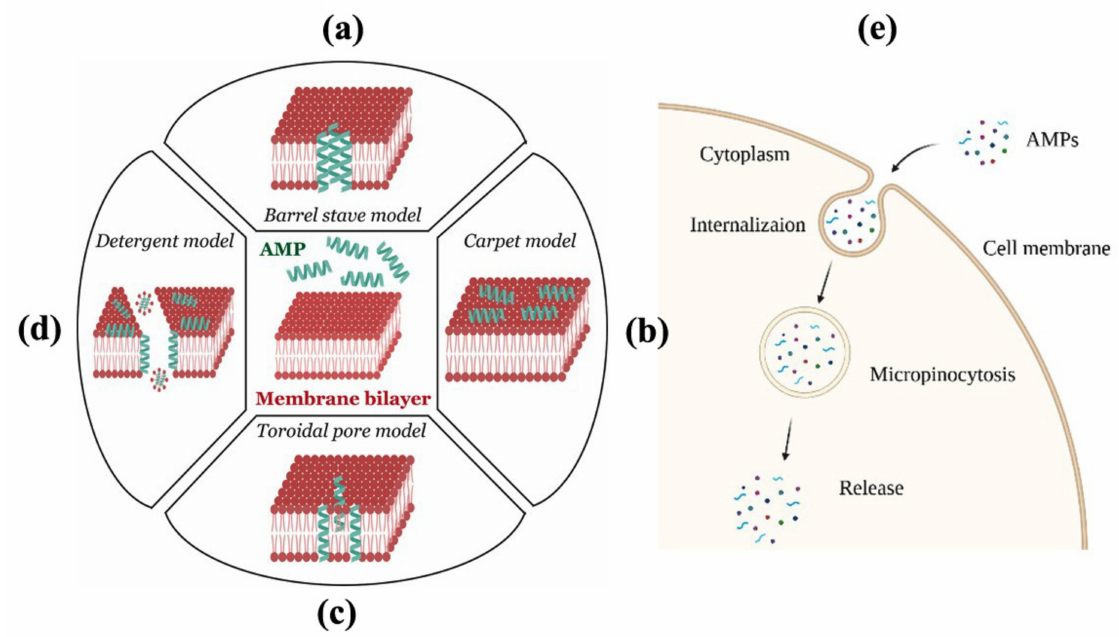
Figure 4. Energy independent and dependent mode of action of plant-derived AMPs. The energy-independent mechanism follows four different models ( a – d ), and the energy-dependent mechanism follows micropinocytosis ( e ) to release AMPs in the